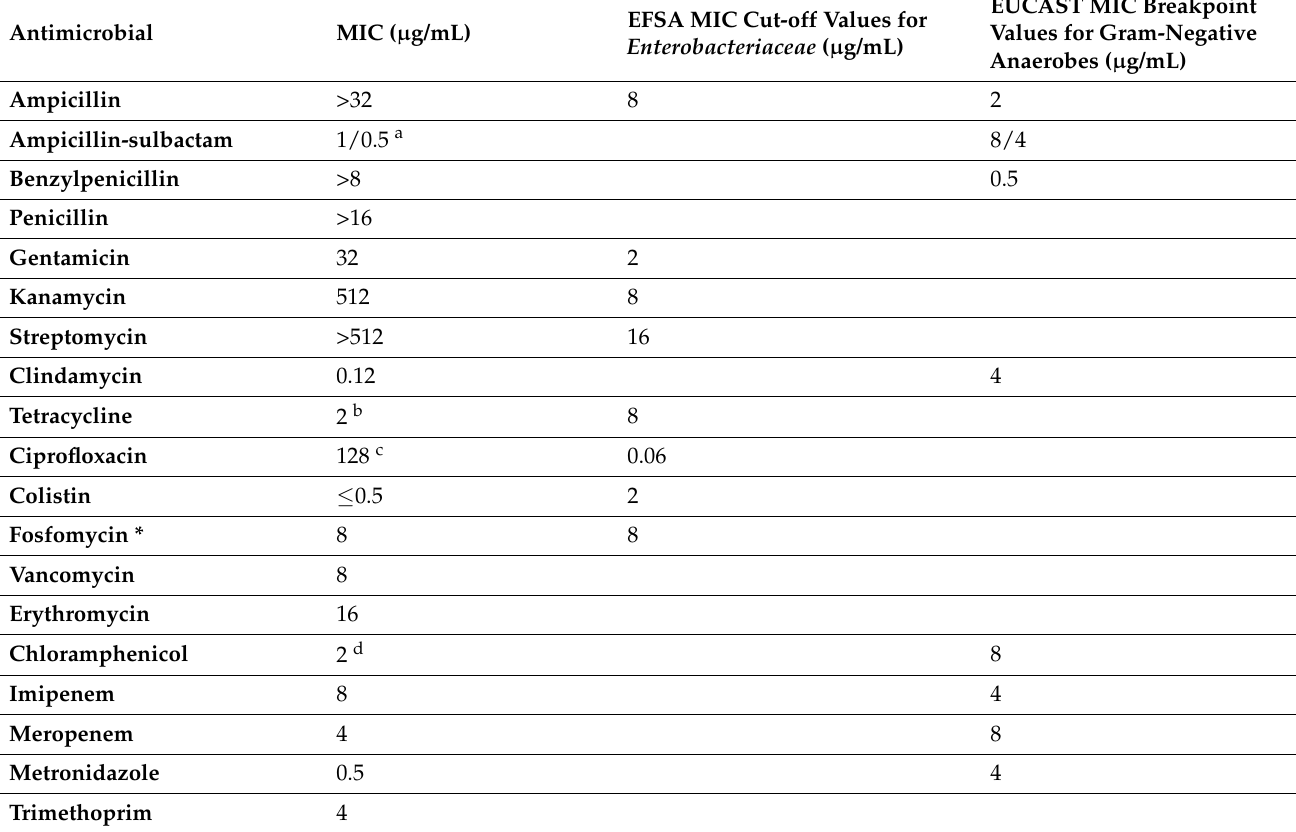
Table 2. Susceptibility of Akkermansia sp. DSM 33459 to selected antimicrobials using YCFAC broth or RMFC agar